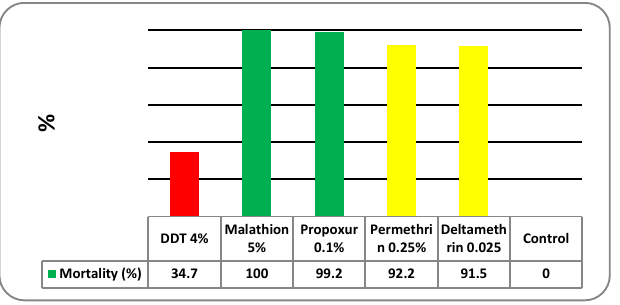
Figure 2: Susceptibility status of An. sacharovi to different insecticides in Dashte Arzhan area, Fars Province, Southern Iran, 1997